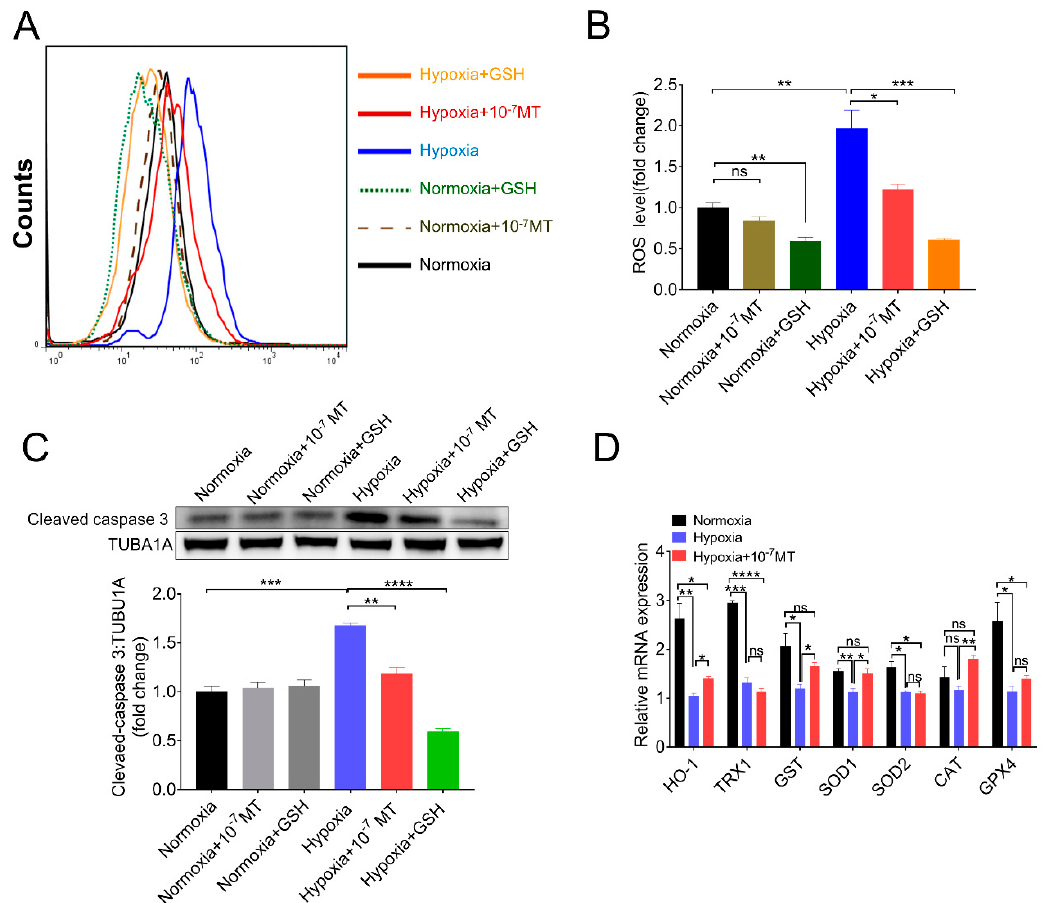
Figure 3. MT-mediated GCs protection during hypoxia is partly dependent on its antioxidant activity. ( A ) The flow cytometry analysis of ROS levels of porcine GCs. ( B ) Quantitative analysis of ROS levels. ( C ) The Western blot analysis of cleaved caspase − 3 in porcine GCs treated with MT and glutathione (GSH). ( D ) The relative mRNA expression level of antioxidant enzymes of porcine GCs cultured in normoxia, hypoxia, and hypoxia plus 10 − 7 M MT. * p < 0.05 was considered significant; ** p < 0.01 was considered highly significant; *** p < 0.001 was considered very significant; **** p < 0.0001 was considered extremely significant; ns p > 0.05 was considered no significant.